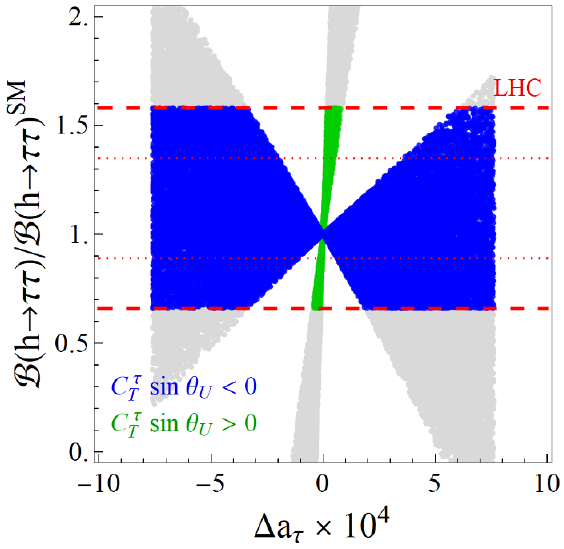
Figure 5 . (cid:1) a (cid:28) is plotted against ( h (cid:28)(cid:28) ) = ( h (cid:28)(cid:28) ) SM for the points allowed by ( g B ! B ! R to 1 (cid:27) accuracy. Color code is the same as in (cid:12)gure 4, i.e. blue and green points are allowed D ( (cid:3) ) by all observables, including ( g 2) (cid:22) and R , while the gray points are excluded by the LHC D ( (cid:3) ) (cid:0) constraints on h (cid:28)(cid:28) , cf. eq. !